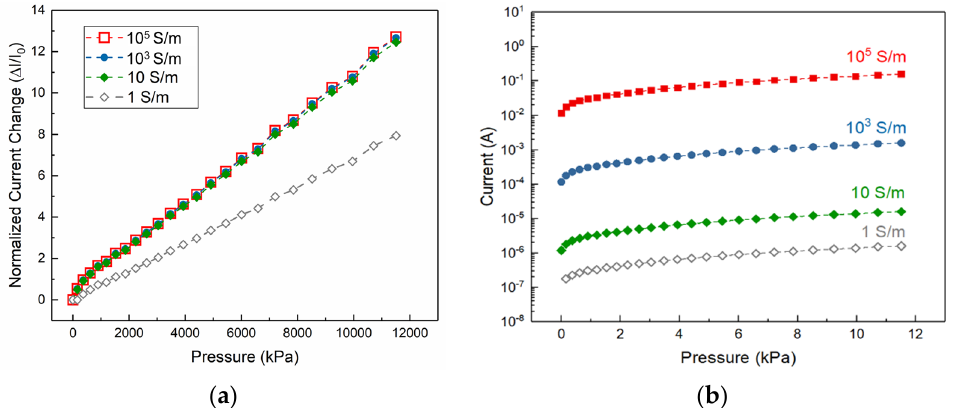
Figure 3. ( a ) Change in relative current as a function of applied normal pressure. ( b ) Current response of the sensor with different conductivity values.